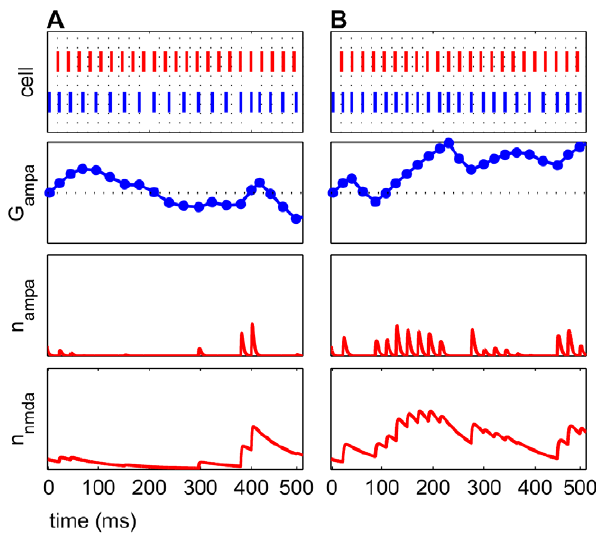
Figure 11. Greater glutamate availability increases potentia- tion. The top panel in each subfigure shows a raster plot of input spikes (red) and E cell spikes (blue). Second panels are AMPAR conductances G ampa over time. Third panels are AMPAR current open probabilities n ampa . Bottom panels are NMDAR current open probabil- ities n nmda . The frequency regimes are the same ( f N ~ 36 Hz. f I ~ 48 Hz). (A) t glu ~ 1 : 2 ms . This frequency regime potentiated briefly. (B) t glu ~ 2 : 1 ms . Input spike times are identical to (A), but greater and prolonged potentiation was